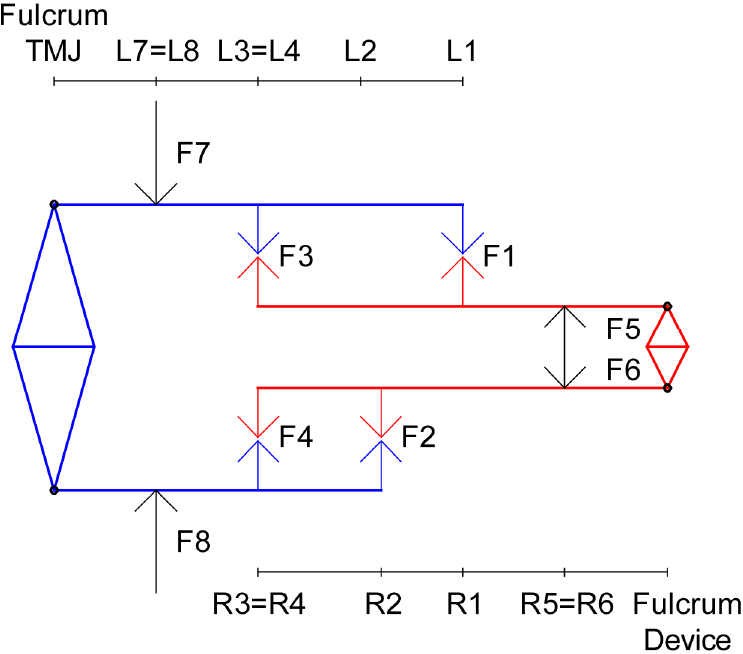
Figure A1. Schematic representation of masticatory system (blue) and device (red) model system. F7 and F8 are equal and opposite forces exerted by the masseter, F5 and F6 force recorded by the sensor. For simplicity, only two points of contact between the mouth and the device are considered for each arch: F1 and F3 for the upper part, F2 and F4 for the lower one.